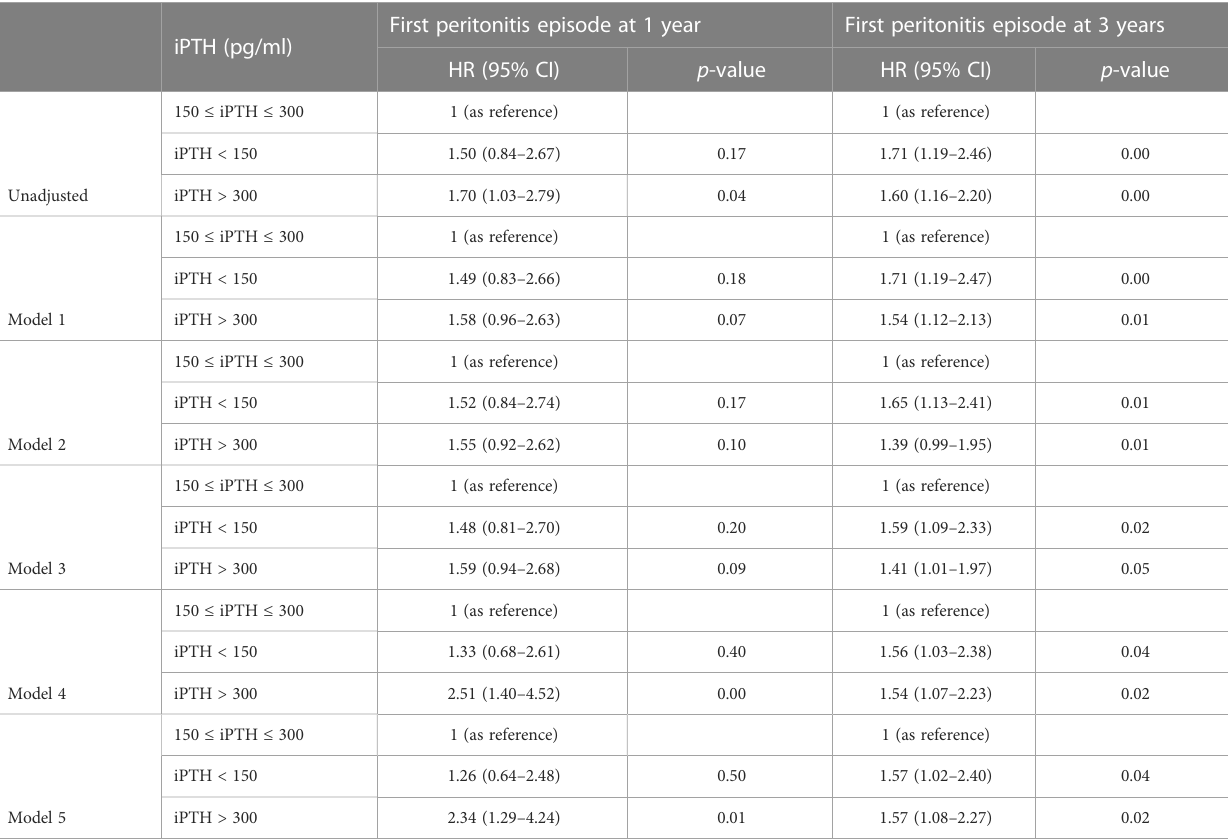
TABLE 3 Cox regression models of the fi rst peritonitis episode for serum intact parathyroid hormone (iPTH) level (150 and 300 pg/ml as categories).